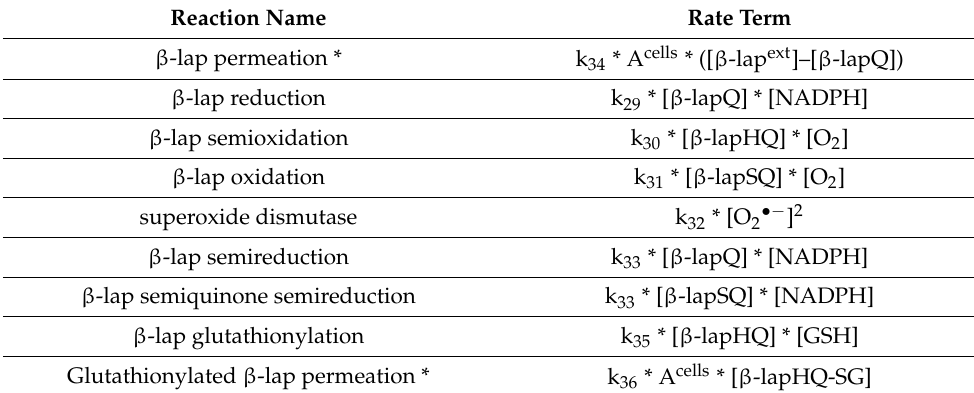
Table 1. Additional rate terms for ODE